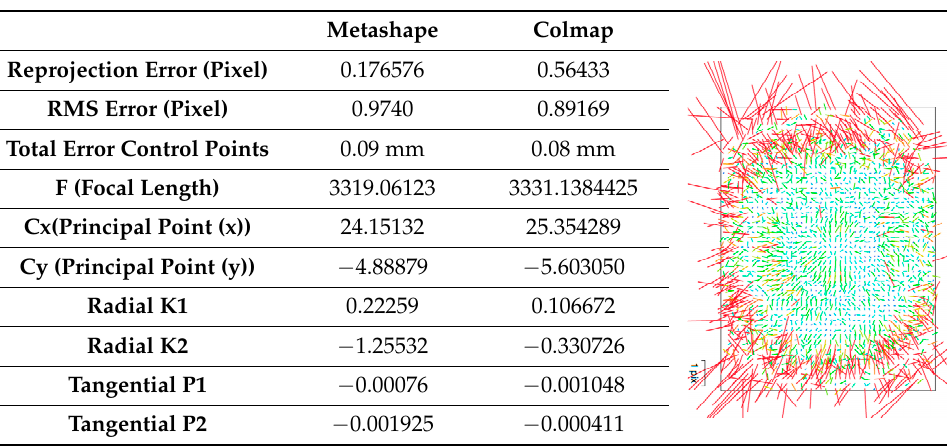
Table 9. Camera calibrated vs. uncalibrated comparison for the iPhone X camera: focal length 4 mm (35 mm eq. 28 mm), ISO 100 f-stop 1.8.